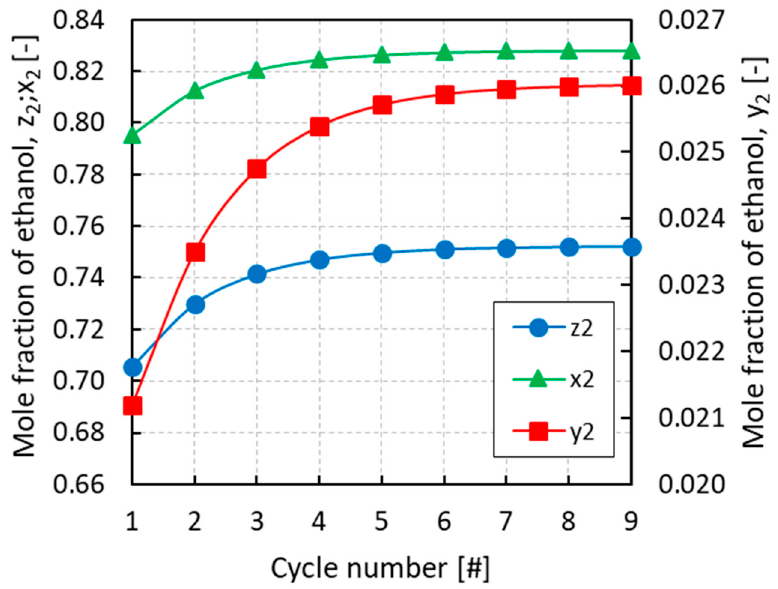
Figure 4. Evolution of the overall mole fraction ( z 2 ), the mole fraction in the vapor phase ( y 2 ), and the mole fraction in the liquid phase ( x 2 ) of ethanol in the evaporator with the cycle number for an initial overall mole fraction of ethanol z 2 = 0.75.